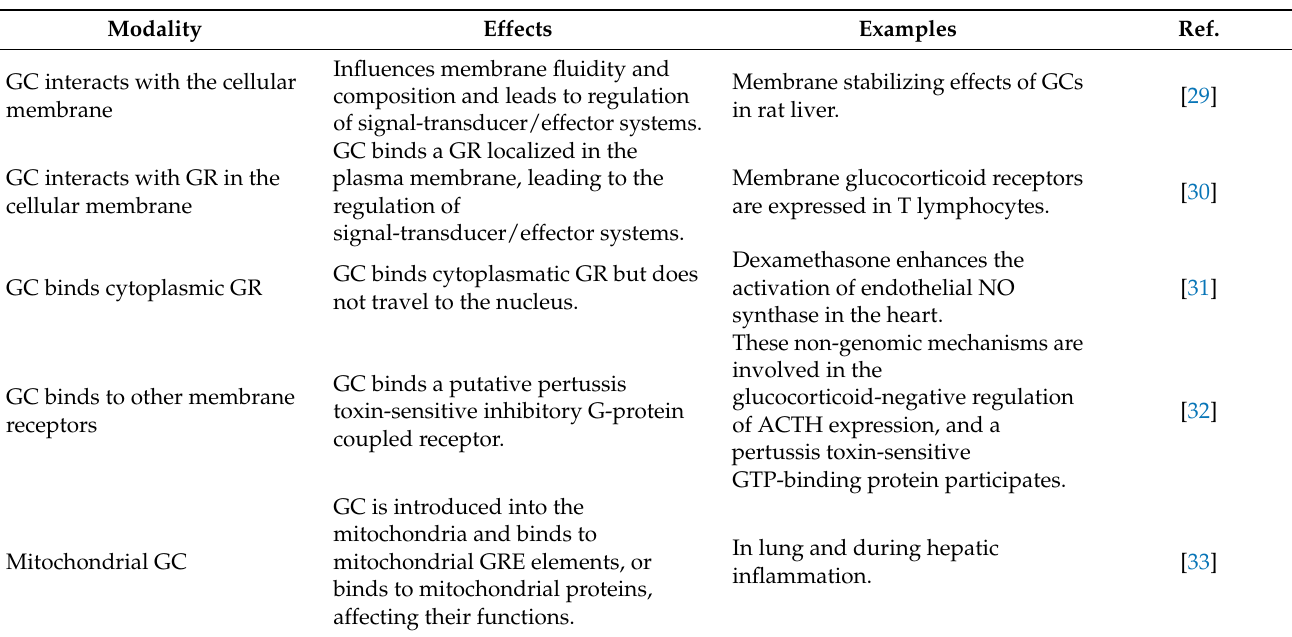
Figure 1. Genomic and Non-genomic effects of GCs. p23: a protein associated with progesterone receptor (23 kDa), HSP70 (70 kDa), and HSP90 (90 kDa): are heat shock proteins, FKBP52: FK506 binding protein (52 kDa), AC: acetylcholine. Created by Biorender. Table 2. Genomic and non-genomic effects of